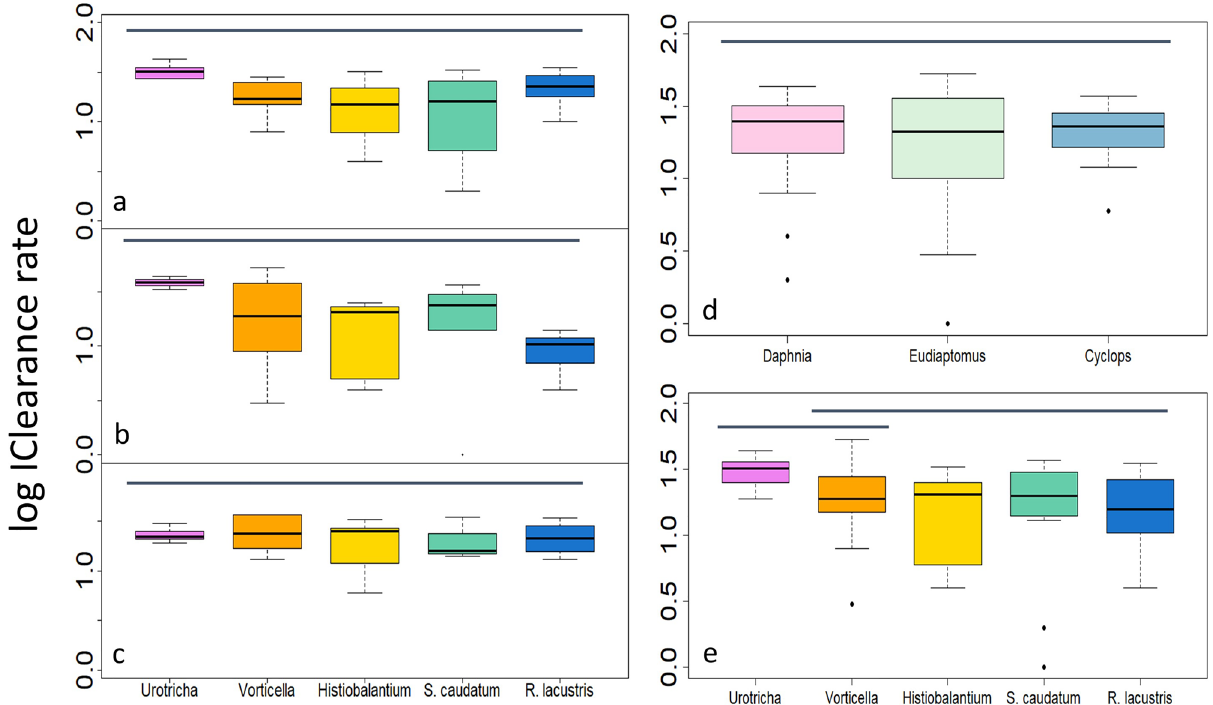
Figure 2. Log 10 –transformed clearance rates (logCL, mL individual −1 d −1 ) of Daphnia ( a ), Eudiaptomus ( b ) and Cyclops ( c ) on the five ciliate species and on all ciliates combined ( d ). Combined logCL of the predators on each ciliate species is shown in ( e ). The horizontal bars indicate logCL that were not significantly different from each